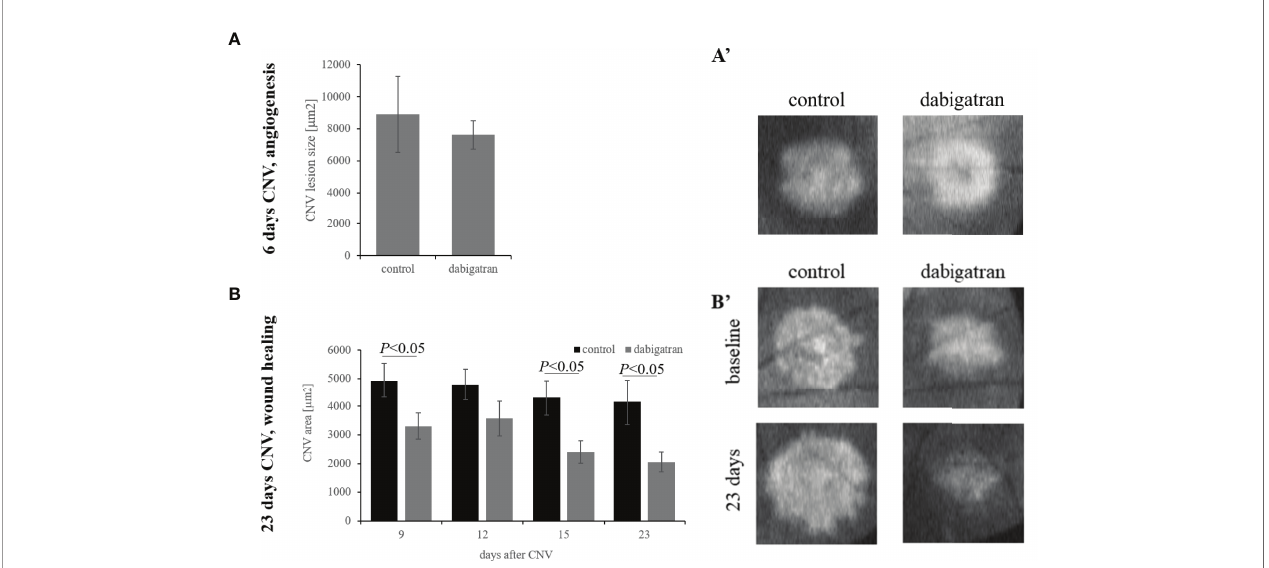
FIGURE 1 | Dabigatran does not reduce CNV lesion size but does accelerate repair. Argon laser photocoagulation of Bruch ’ s membrane was used to generate four laser spots in each eye of the C57BL/6J mice. Mice were analyzed by OCT on day 5 post laser (A) or on days 5, 9, 12, 15 and 23 during the repair paradigm (B) . Mice were fed standard or dabigatran chow (~10 mg/kg bodyweight per day) during either the induction phase of the CNV lesion or during the repair phase, starting at day 5. Quanti fi cation of the lesion areas using image J analysis on OCT images demonstrate no reduction in CNV size in the short-term paradigm, and an acceleration of repair in dabigatran-fed mice. Data shown are average values ( ± SEM) per lesion and corresponding representative images of CNV lesions are shown.